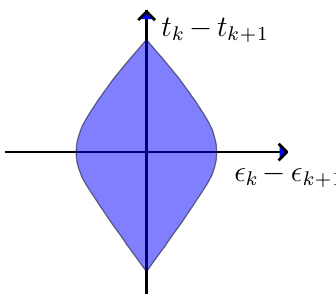
˜ G is holomorphic, to the plane ( (cid:15) k −